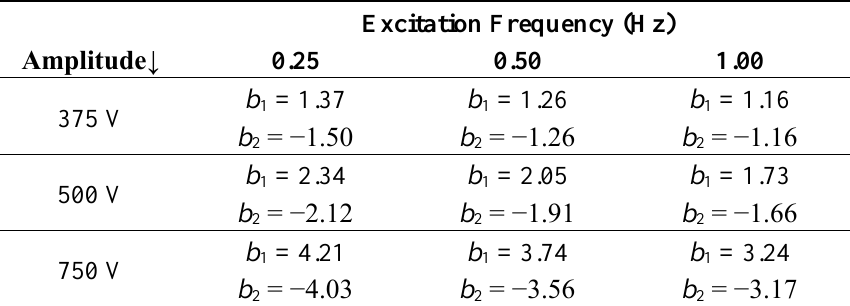
Table B1. Saturation parameters.